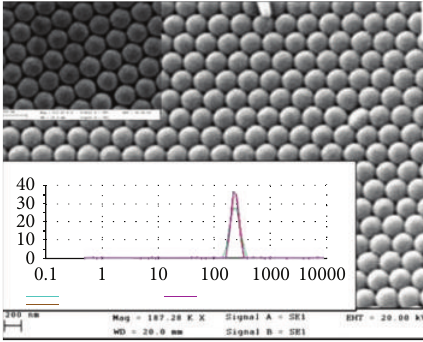
Figure 9: Polymer colloidal crystal obtained by soap free emulsion polymerization and DLS spectrum